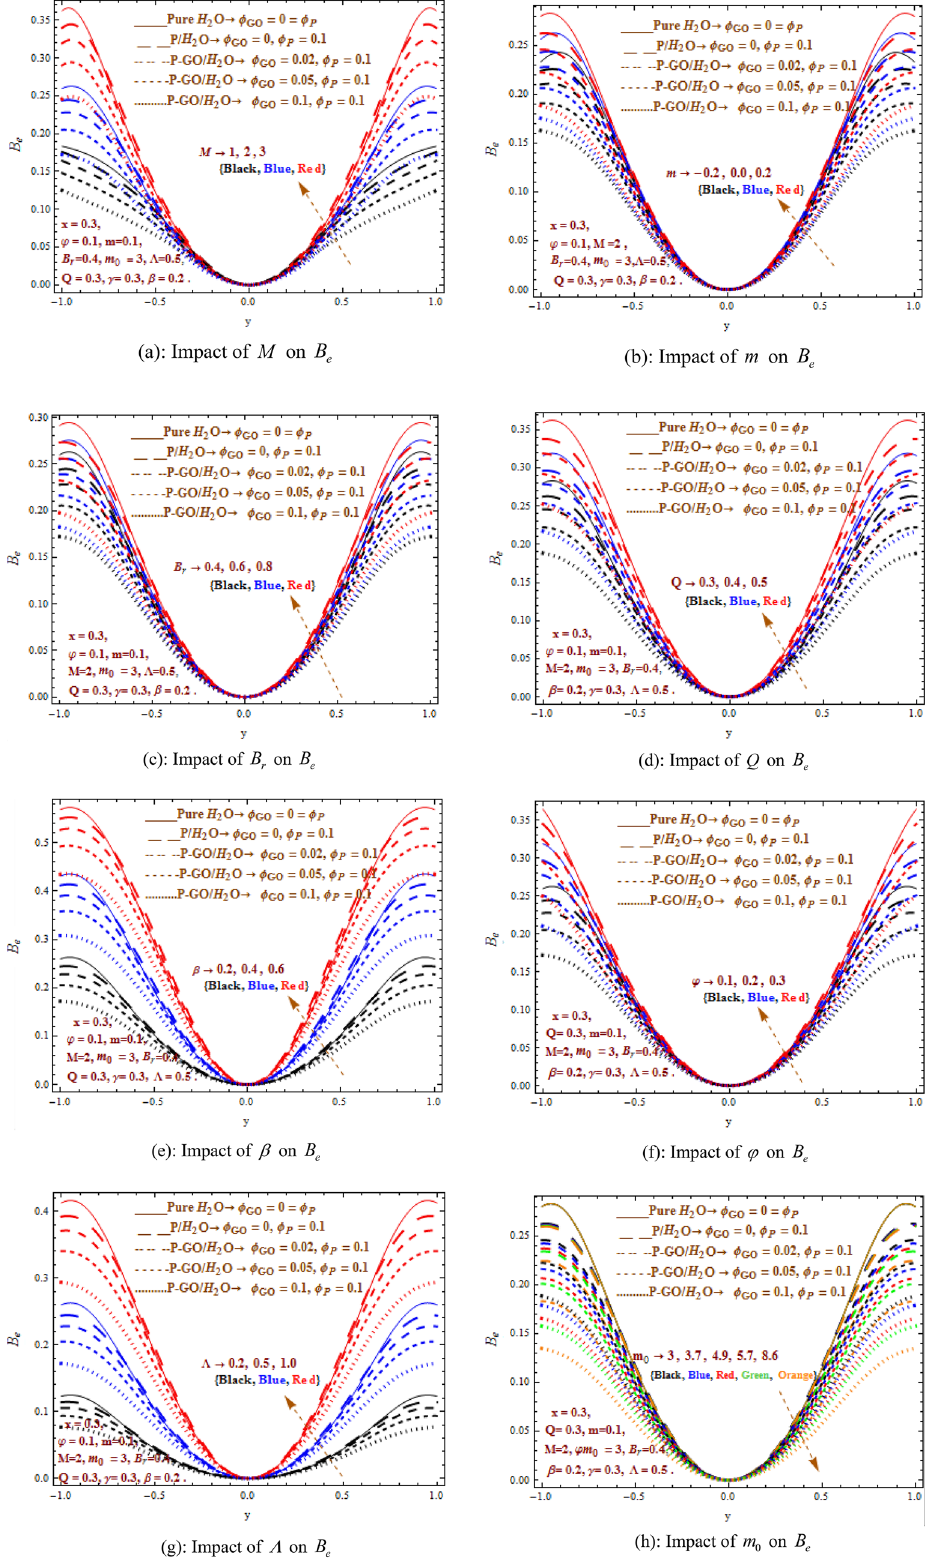
Figure 4. ( a ) Impact of M on B e . ( b ) Impact of m on B e . ( c ) Impact of B r on B e . ( d ) Impact of Q on B e . ( e ) Impact of β on B e . ( f ) Impact of ϕ on B e . ( g ) Impact of (cid:31) on B e . ( h ) Impact of m 0 on B e